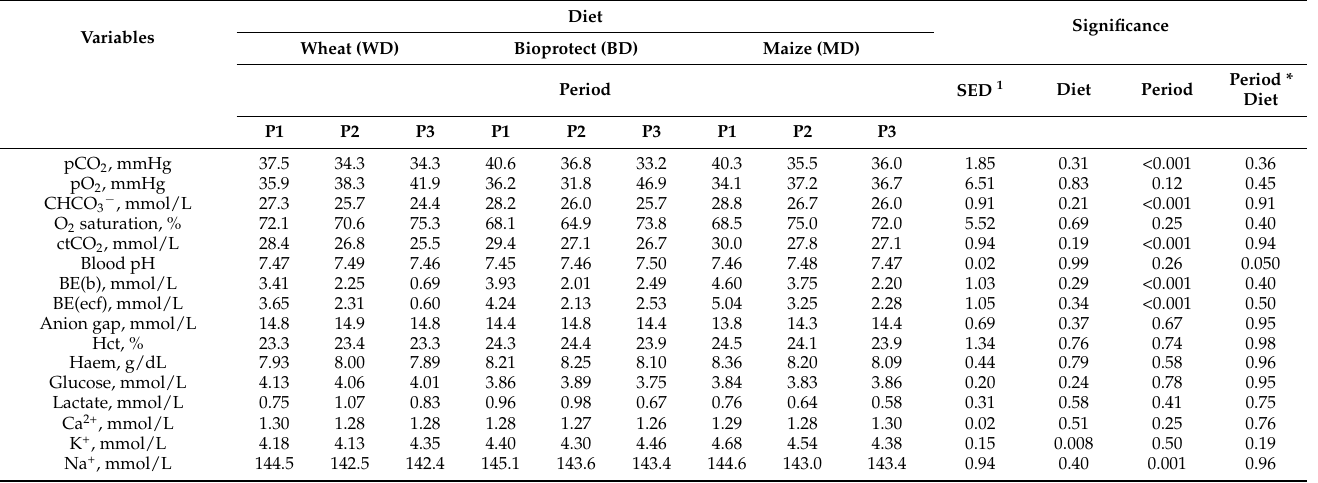
Table 3. Comparative assessment of blood gas profile of lambs fed wheat-based diet, Bioprotect treated wheat-based diet and maize-based diet subjected to different experimental